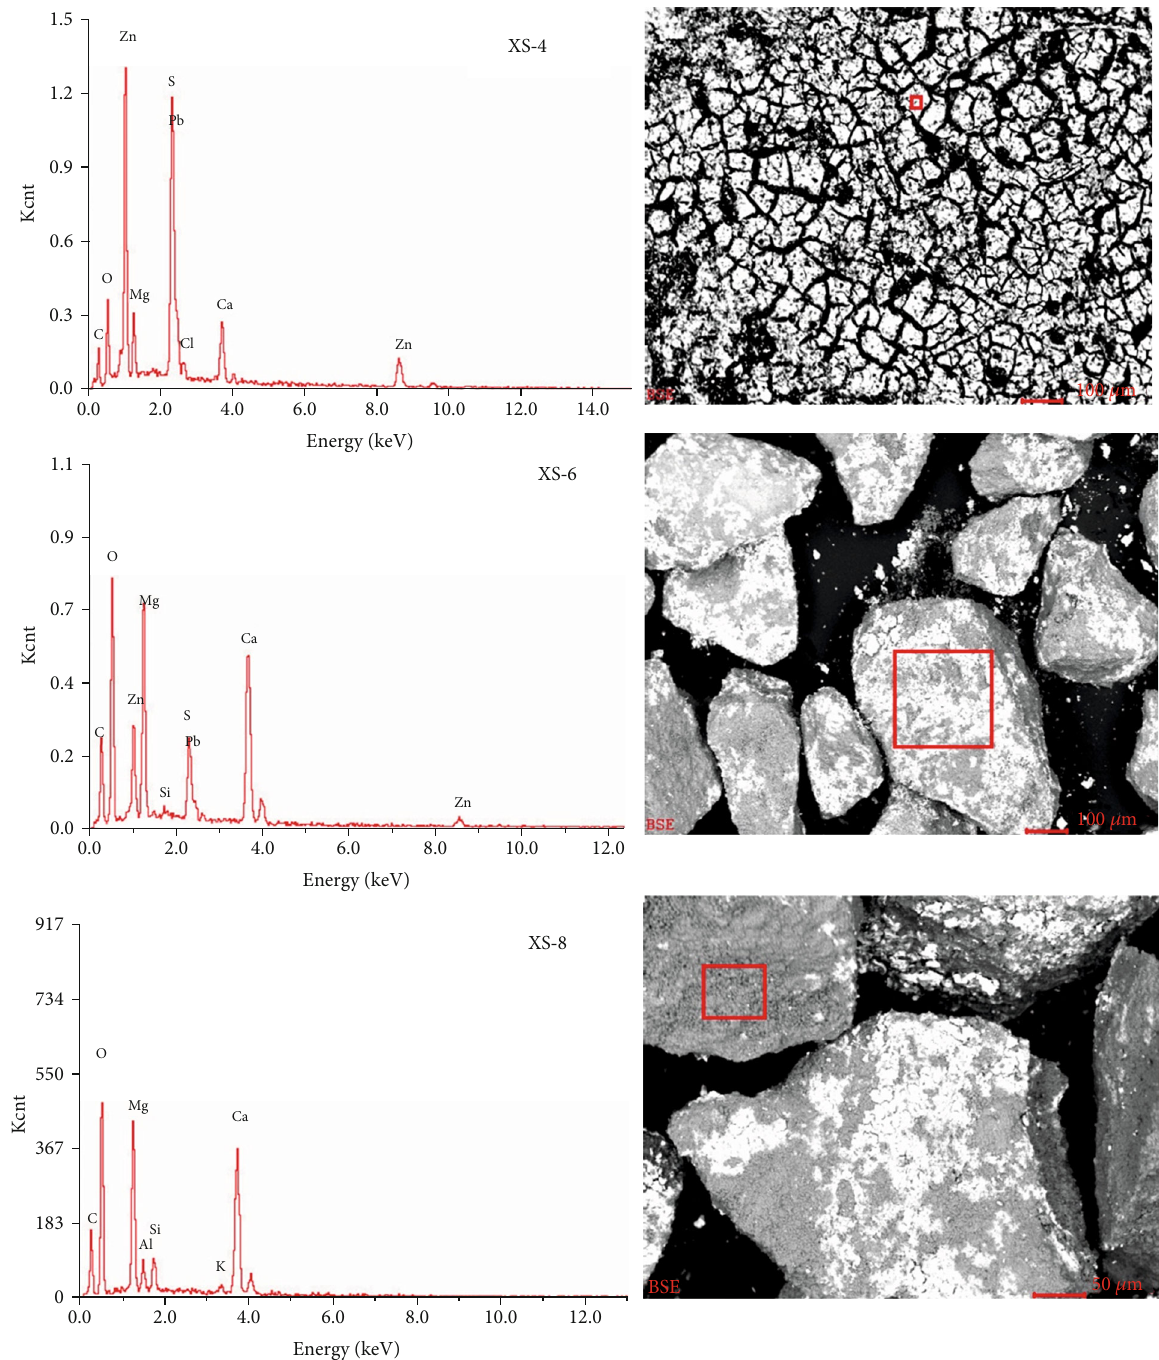
Figure 6: Electron probe patterns for XS-4, XS-6, and